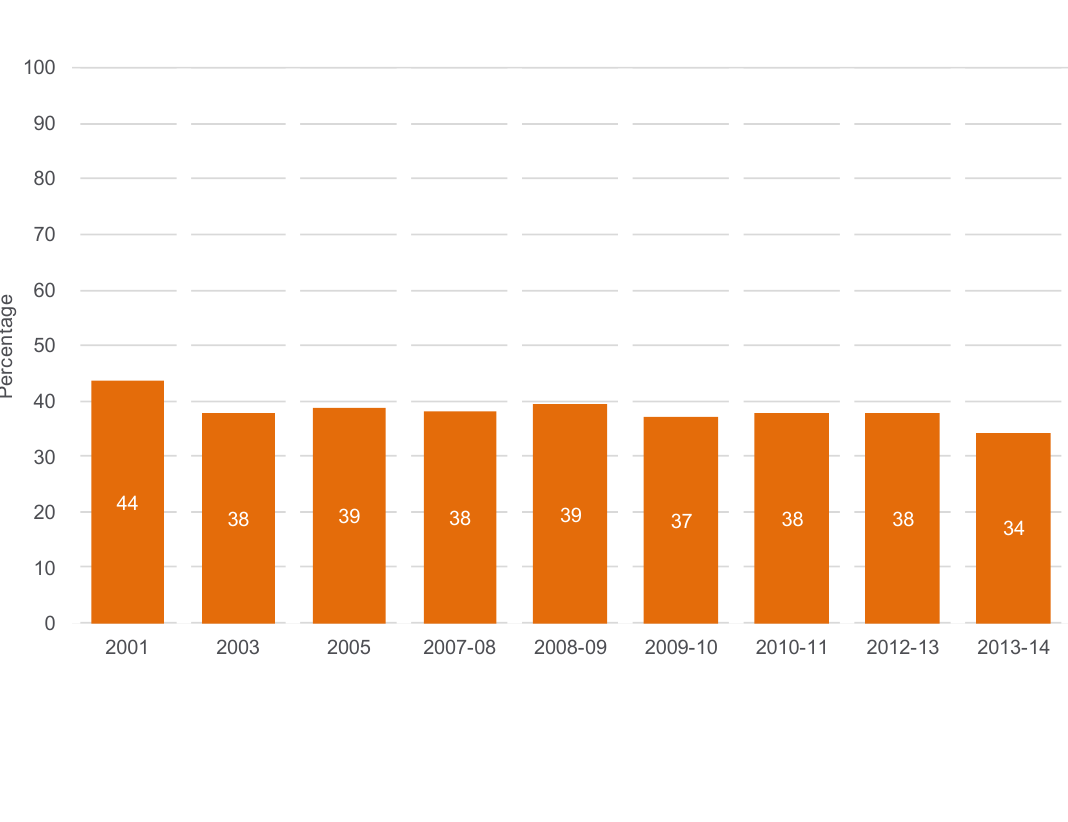
- Table 14: Whether people feel able to influence decisions affecting their local area, 2001 to 2013-14